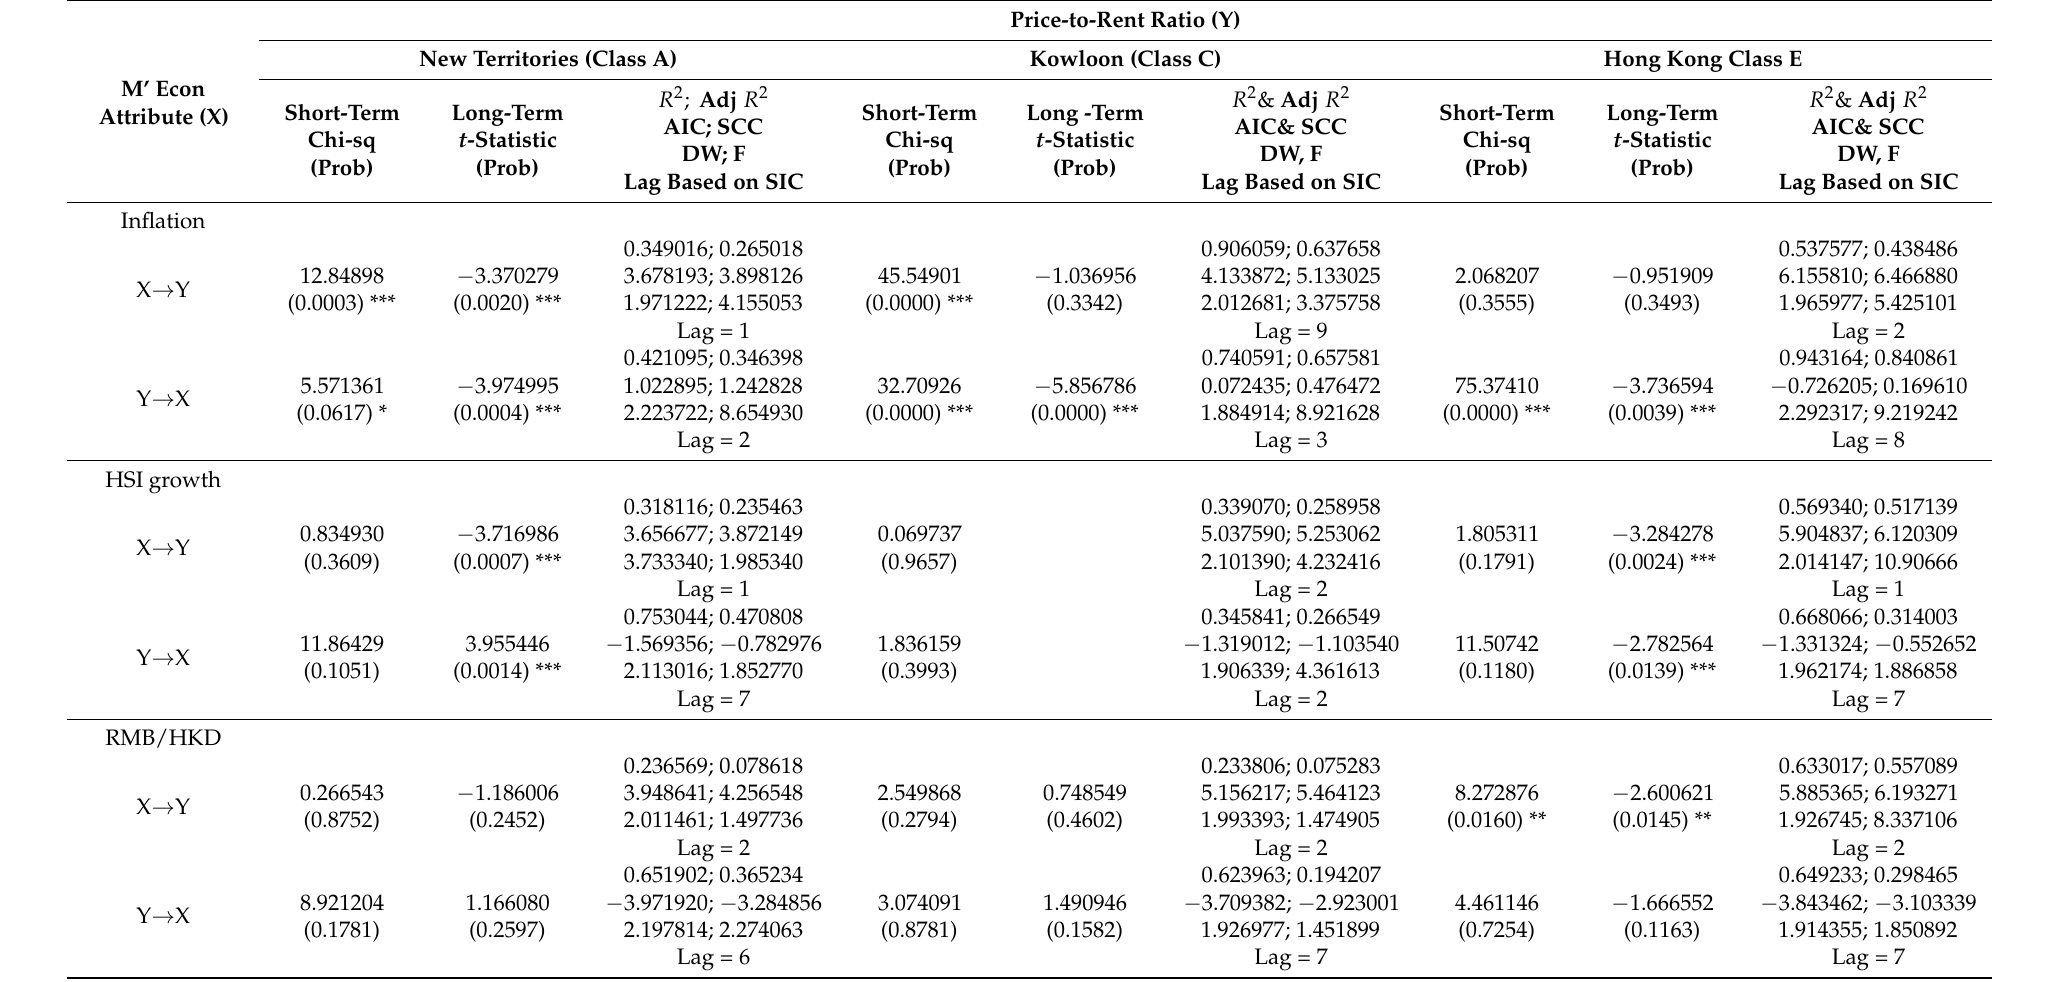
Table 4. Results of Granger Causality